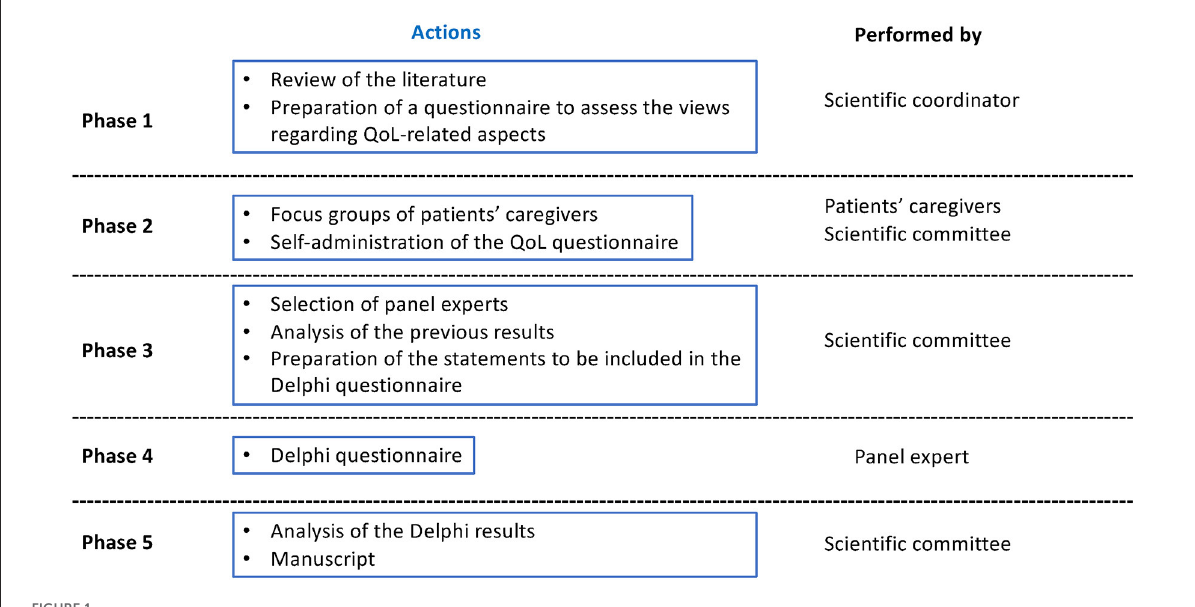
FIGURE1 Study phase